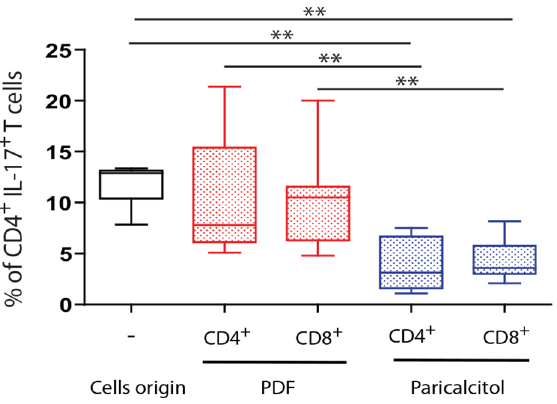
Figure 7. CD4 + and CD8 + T cells from paricalcitol-treated mice regulate IL-17 production. CD4 + - and CD8 + -enriched T cell populations from mice treated with PDF and paricalcitol were stained with PKH67 and co-cultured with CD3 + T cells from PDF-treated mice. A control group of CD3 + T enriched cells from PDF-treated mice was also included. The cells were stimulated with CD3 and CD28, and after 2 days, brefeldin A was added for the last 12 h of culture. The cells were stained with anti-CD4 and anti-IL-17 antibodies and analyzed by flow cytometry. The PKH67 negative CD4 + T cells were selected, and the frequency of IL17 + cells is shown in the figure. Statistical significance was determined using the Mann-Whitney test. ** P , .01.